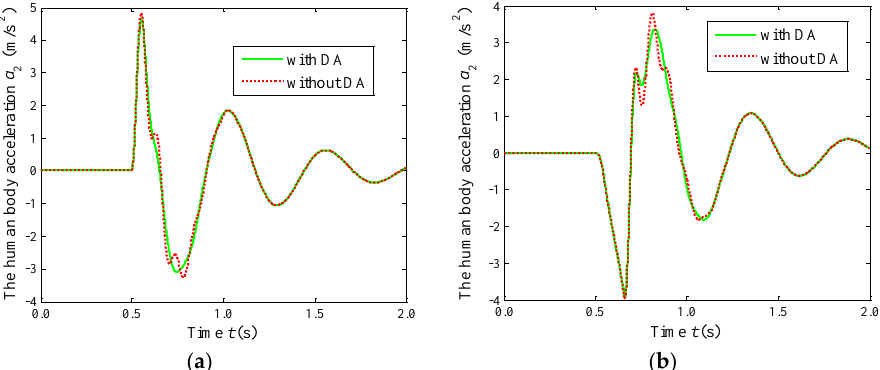
Figure 7. A comparison of the time histories of the human body acceleration a 2 for the system with the DA and without the DA: ( a ) going up the step; ( b ) going down the step.